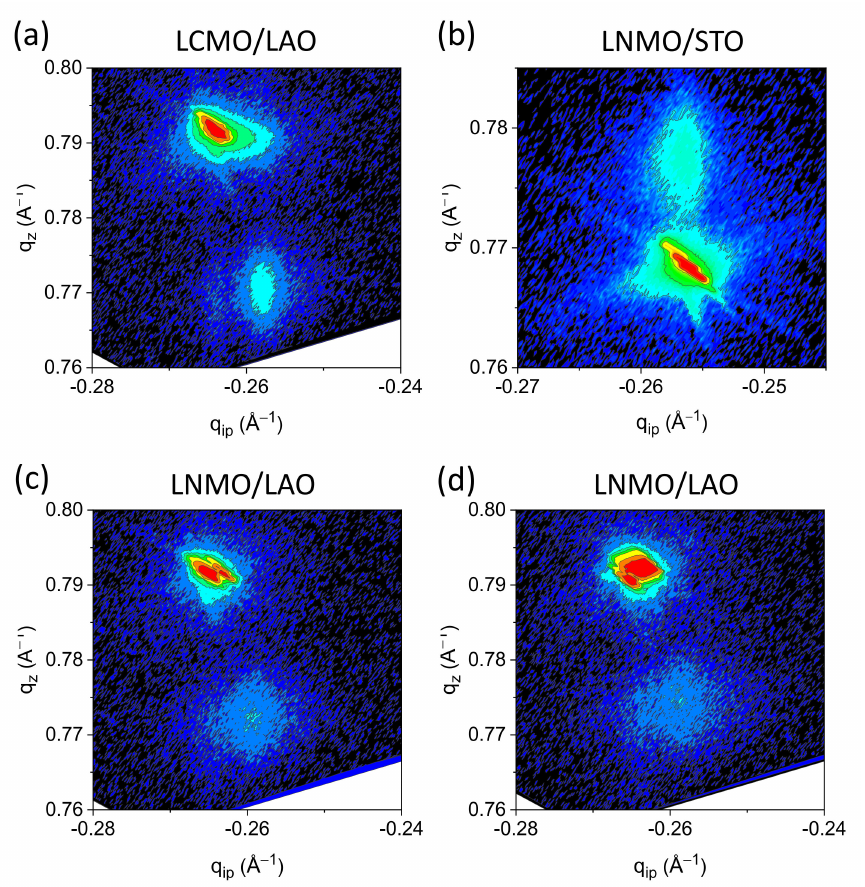
Figure 2. Reciprocal space maps around the (103) substrate reflections for ( a ) LCMO film grown on LAO; ( b ) LNMO film grown on STO; ( c ) LNMO film grown on LAO; treated in RTA conditions, 20 ◦ C / s heating ramp, dwell time 20 min at 900 ◦ C in static oxygen ( d ) LNMO film grown on LAO in RTA conditions, and subsequent high temperature conventional annealing in oxygen flux (5 ◦ C / min, 750 ◦ C, 120 min, 0.5 L / min